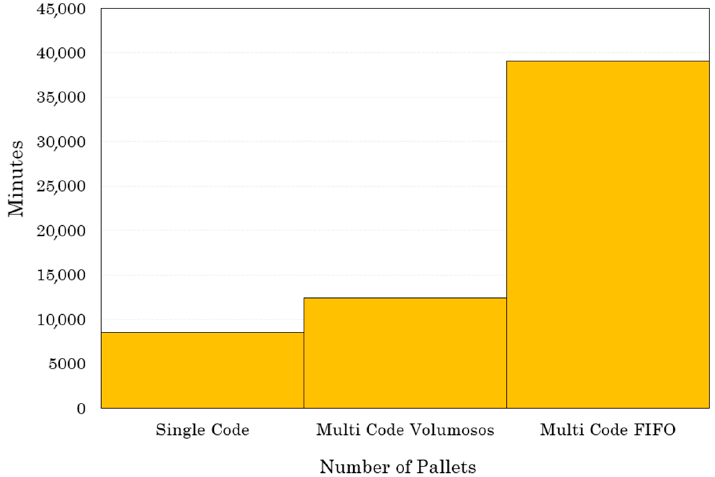
Figure 5. Time (in minutes) spent processing each type of pallet in November 2020.